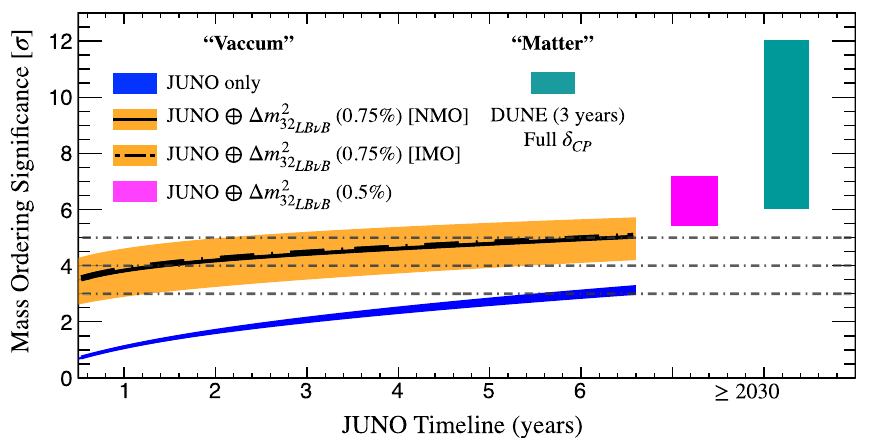
Figure 8. Different measurements of mass ordering. As illustrated in Fig. 7, the LB ν B-II generation may provide major boosting of the JUNO sensitivity upon the boosting caused by (cid:31) m 2 32 precision, which is expected to be at best ≥ 0.75% . The boosting effect is again illustrated as the difference between the JUNO alone (blue) and JUNO boosted (orange) curves. However, once the LB ν B-III generation accelerator experiments start, we expect the (cid:31) m 2 32 precision to be further enhanced up to ∼ 0.5% by both DUNE and HK. At this moment,